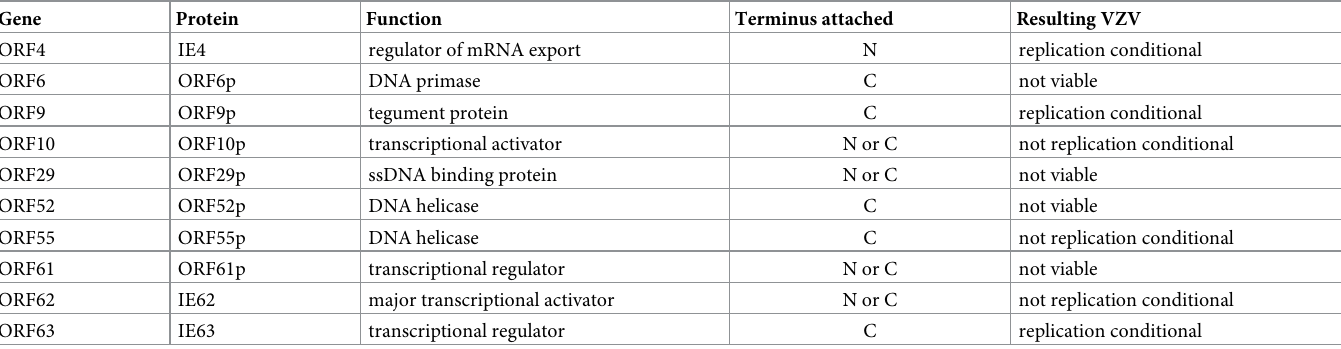
Table 2. Developed VZV BAC and degron containing VZV